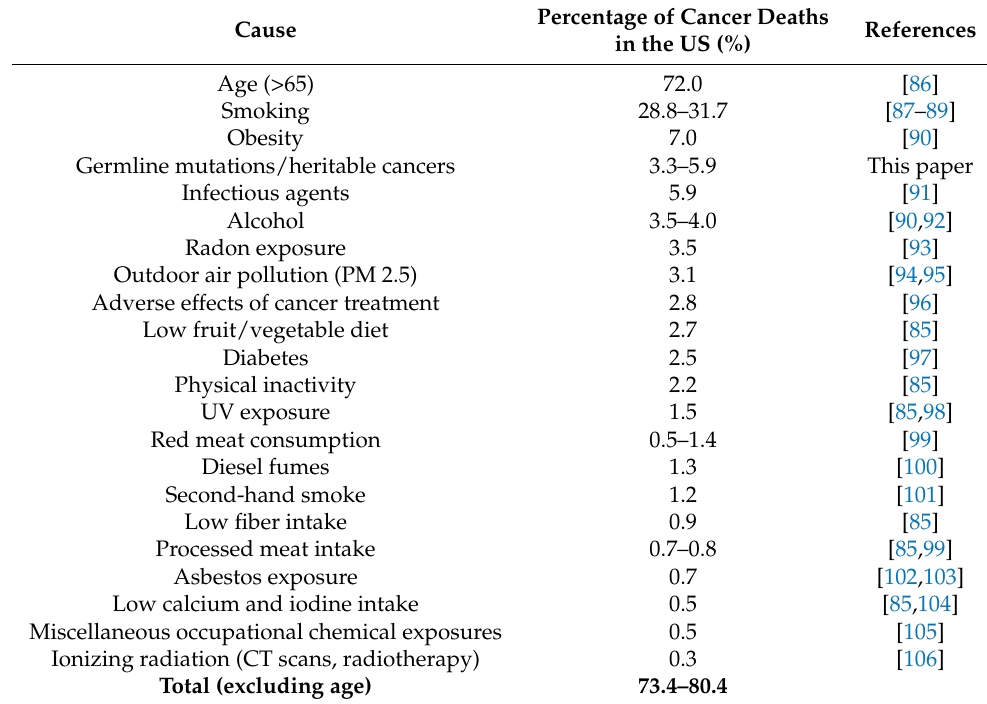
Table 2. Risk factors and causes of cancer deaths in the United